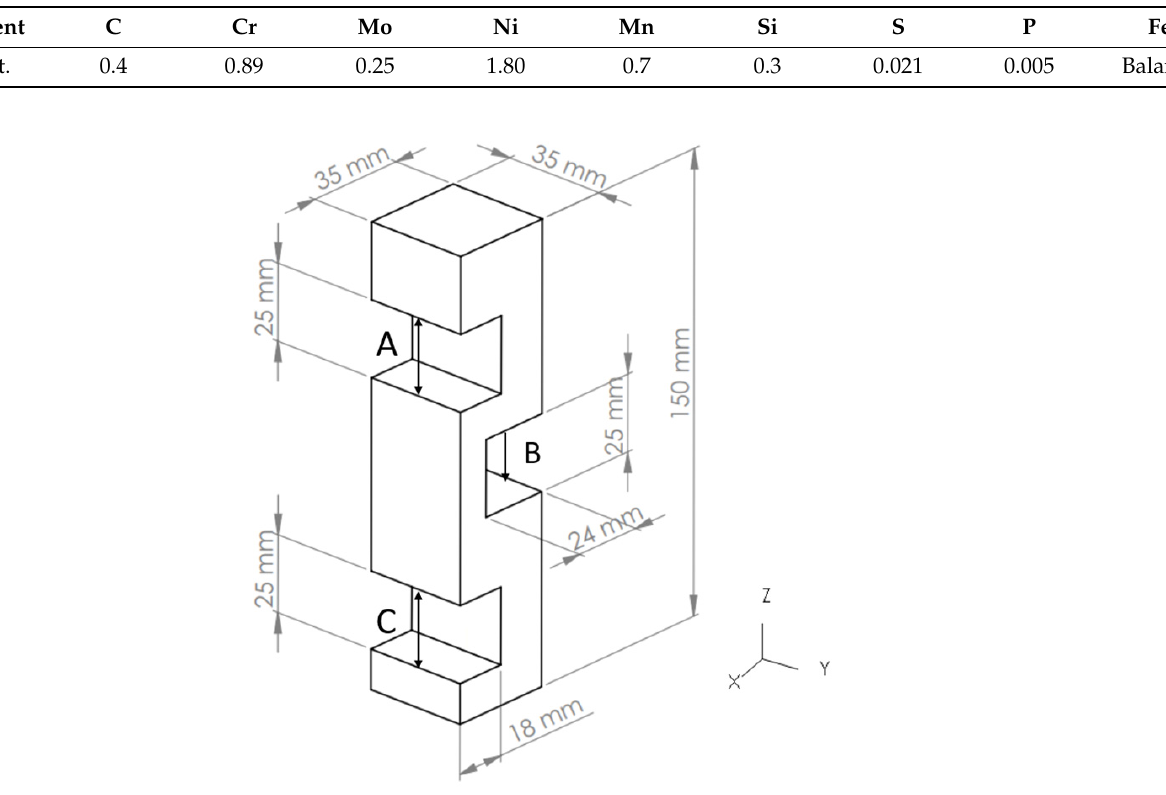
Table 1. Chemical composition of AISI 4340 steel.